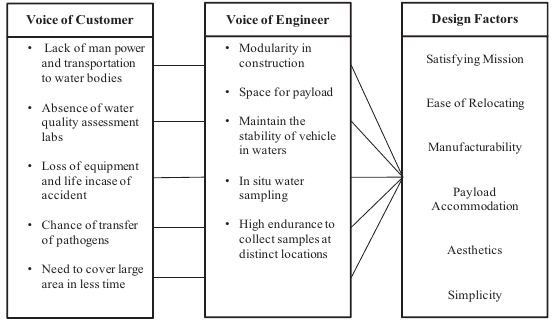
Figure 3. Design factors of UAAV by an affinity wall